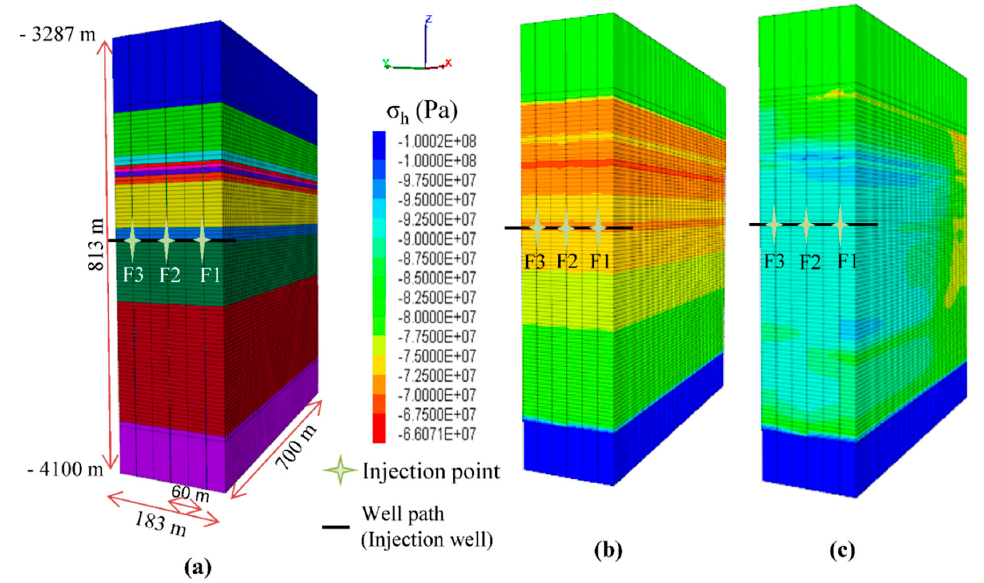
Figure 16. 3D 1 model showing injection points of fractures 1, 2, and 3 with ( a ) 60 m fracture Figure 16. 3D ½ model showing injection points of fractures 1, 2, and 3 with (a) 60 m fracture spacing, 2 spacing, ( b ) prevailing minimum horizontal stress before fracturing, and ( c ) minimum horizontal stress (b) prevailing minimum horizontal stress before fracturing, and (c) minimum horizontal stress after after fracturing. fracturing. Table 2. Injected fluid and rock parameters for multi-fracture